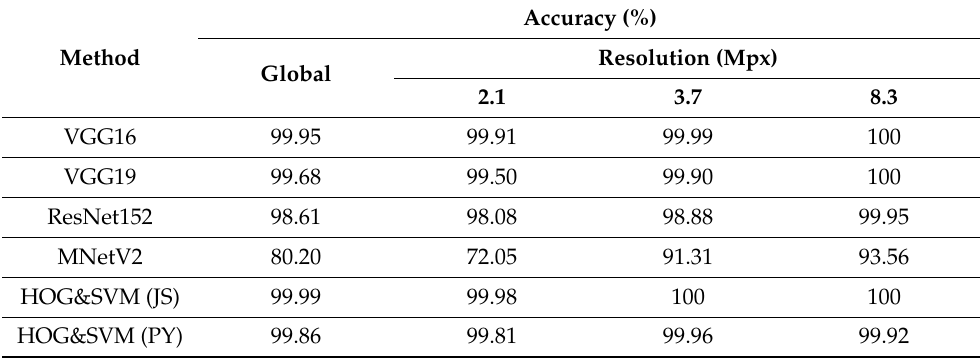
Table 7. Accuracy results of the tests performed on the tactode_big test dataset and their distribution by the available resolutions.